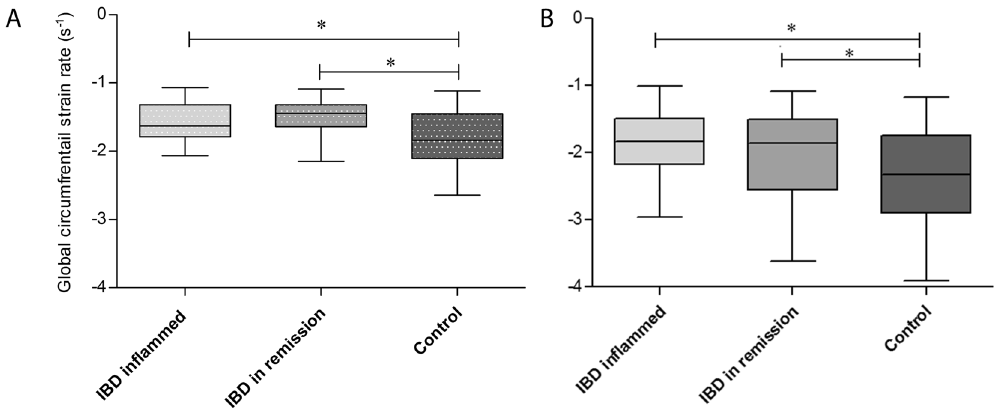
Figure 1. Global LV peak circumferential strain rate at rest ( left ) and during exercise testing ( right